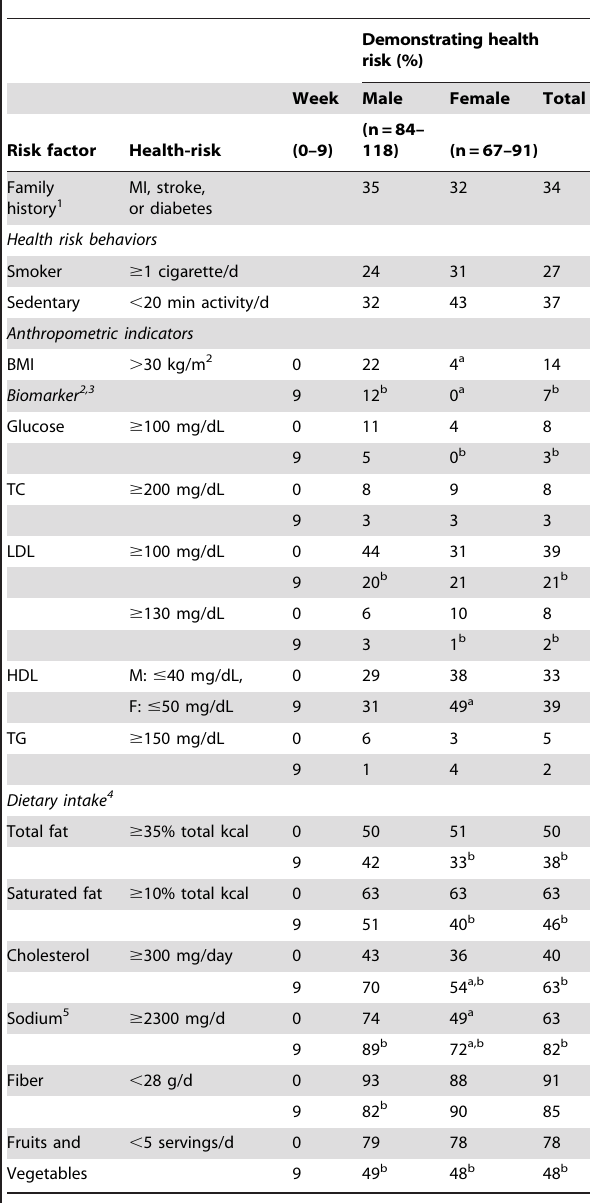
Table 1. Percentage of US Army recruits demonstrating health-risk behaviors and having blood glucose or lipid levels indicative of increased cardiometabolic risk before and after basic combat training.